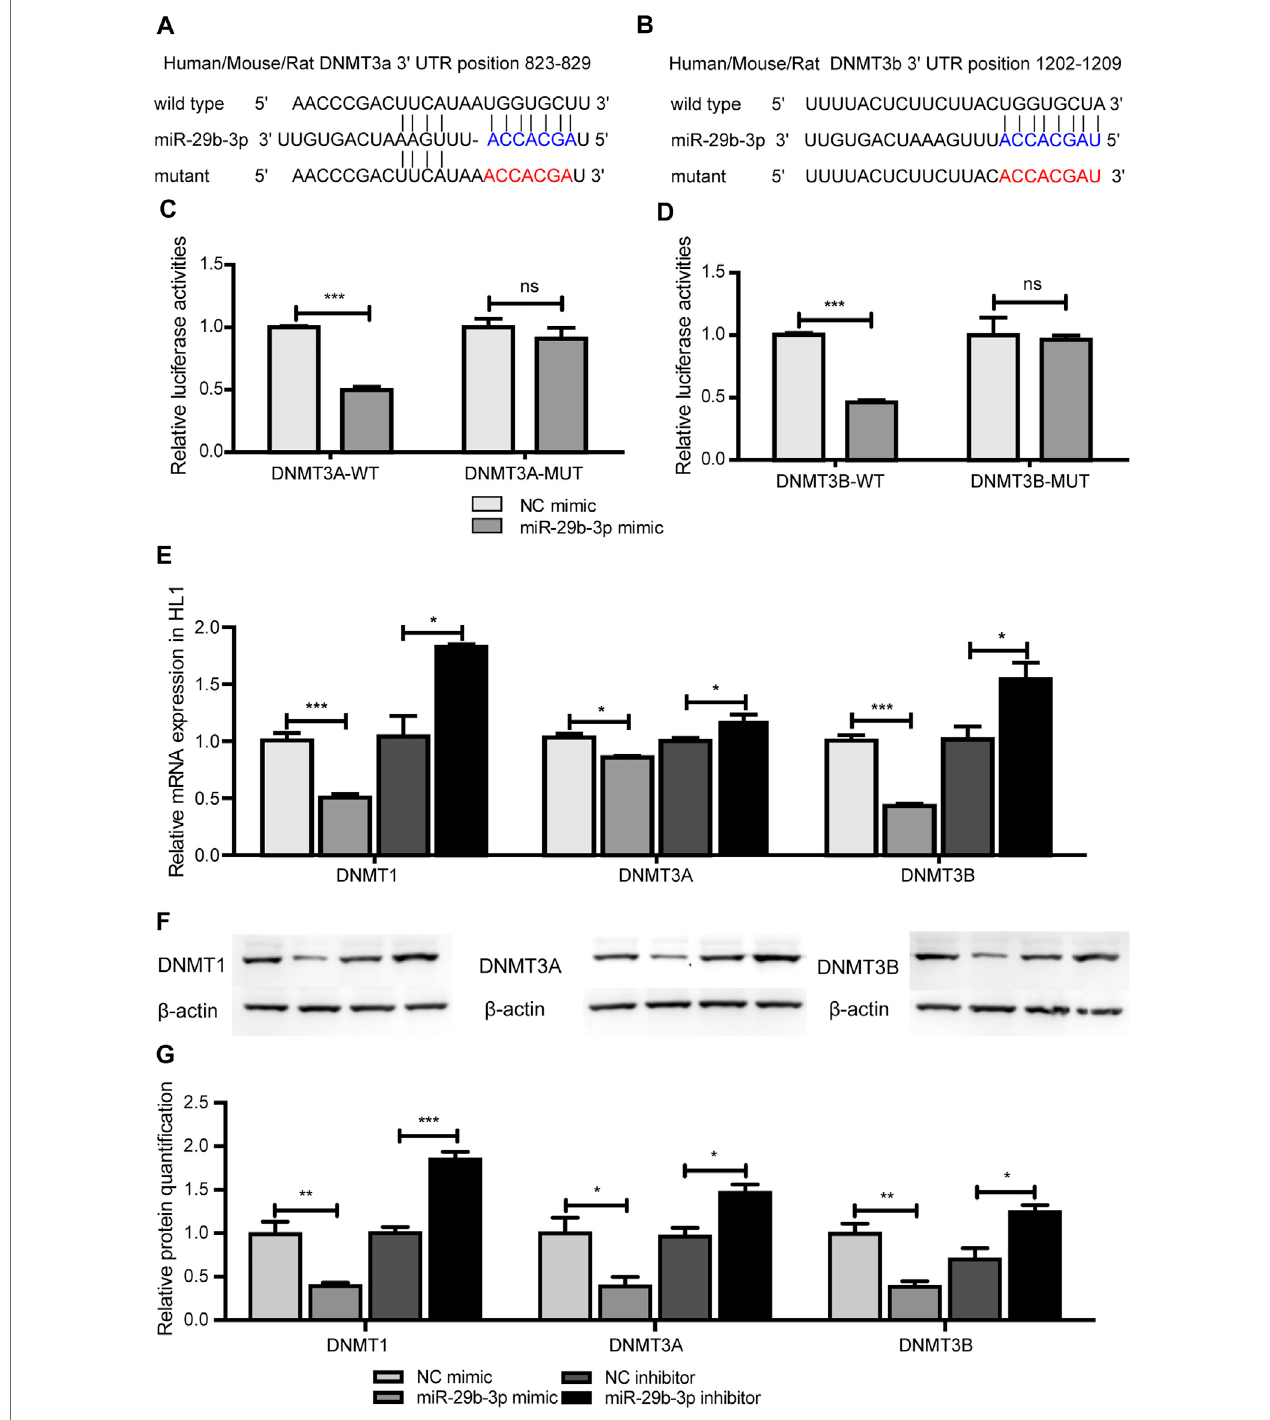
FIGURE 6| The effect of miR-29b-3p on the expression of DNMTs . (A and B) The predicted binding site ofmiR-29b-3p in the 3 ′ untranslated regions of DNMT3A and DNMT3B . (C and D) TherelativeluciferaseactivityofHL1cellscotransfectedwithmiR-29b-3pmimic orNCmimic andplasmidcontainingDNMT3Aor3Bwild-type ormutated3 ′ UTRs.(miR-29b-3pmimic+psiCHECK ™ -2-DNMT3A/3B-3 ′ UTRvs.NCmimic+psiCHECK ™ -2-DNMT3A/3B-3 ′ UTR,*** p < 0.001;miR-29b-3pmimic+ psiCHECK ™ -2-DNMT3A/3B-3 ′ UTR-MUT vs. NC mimic + psiCHECK ™ -2-DNMT3A/3B-3 ′ UTR-MUT, p = ns). (E) mRNA expression of DNMTs in HL1 cells transfected with miR-29b-3p mimic or its inhibitor (miR-29b-3p mimic vs. NC, * p < 0.05, miR-29b-3p inhibitor vs. NC inhibitor, *** p < 0.001). (F) Protein expression of DNMTs in HL1 cells transfected with miR-29b-3p mimic or its inhibitor. (G) Relative quanti fi cation of DNMT proteins ( ns not signi fi cant, * p < 0.05, ** p < 0.01 and *** p < 0.001).